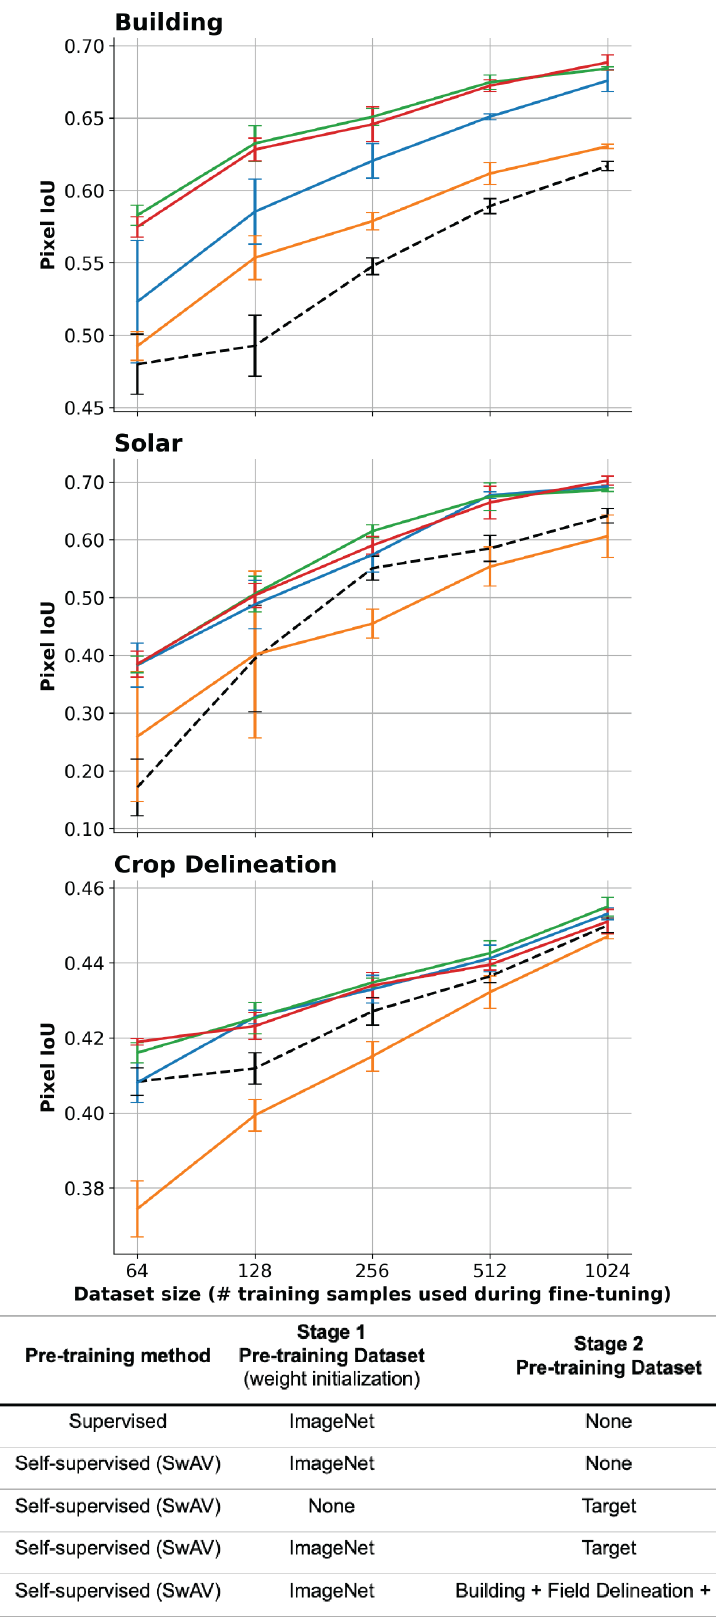
Figure 2. Pixel IoU plotted as a function of the number of labeled training samples used in fine-tuning, with results separated out by